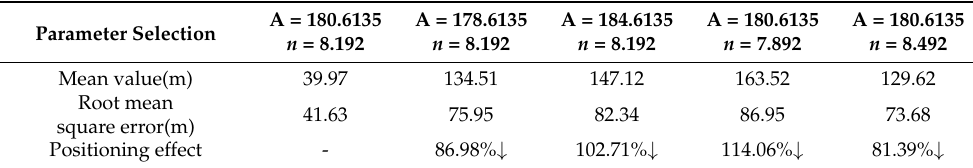
Table 10. Positioning accuracy evaluation Figure 16. Different path loss coefficients of fusion positioning error.